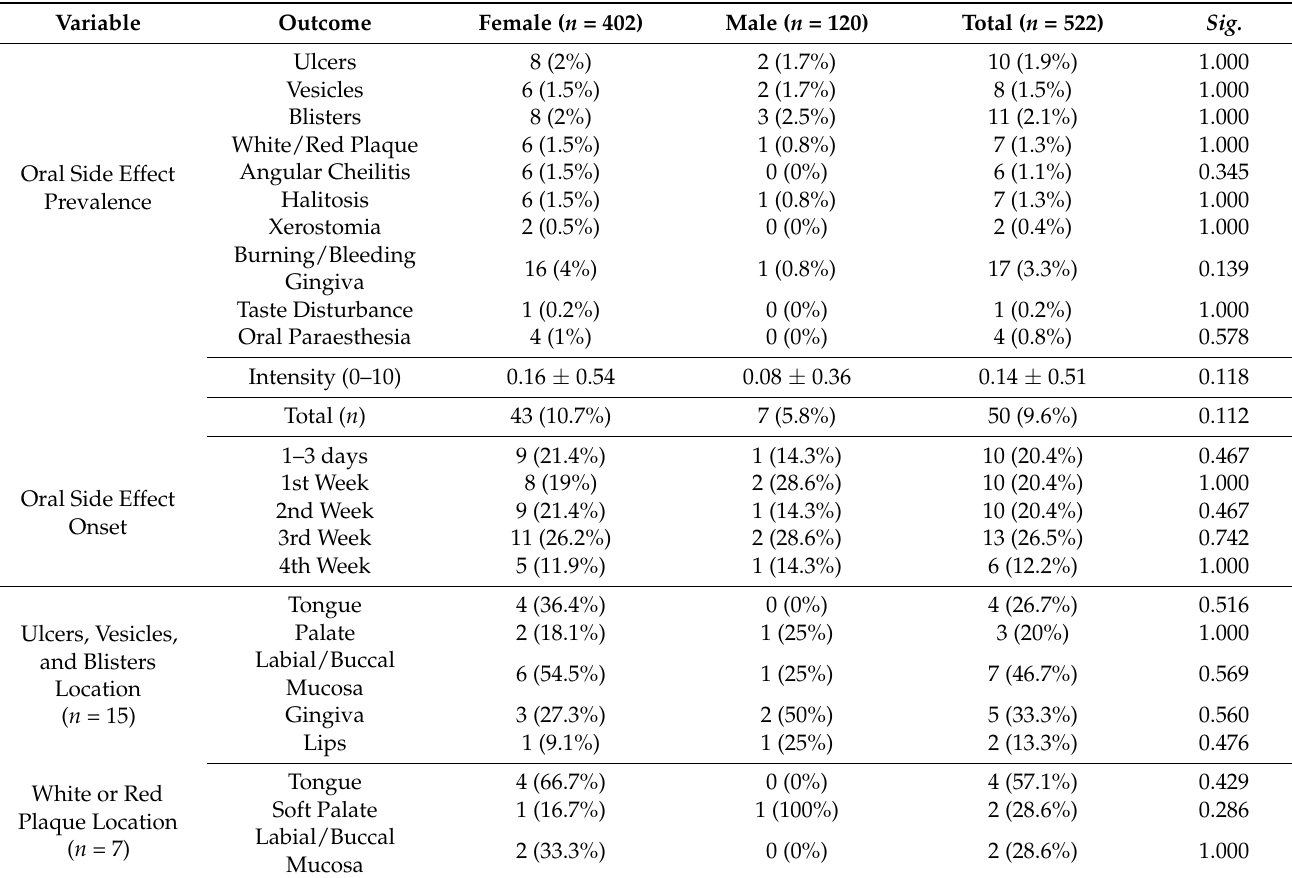
Table 6. Oral side effects of Slovak healthcare workers who received BNT162b2 and stratified by gender, February–March 2021 ( n =